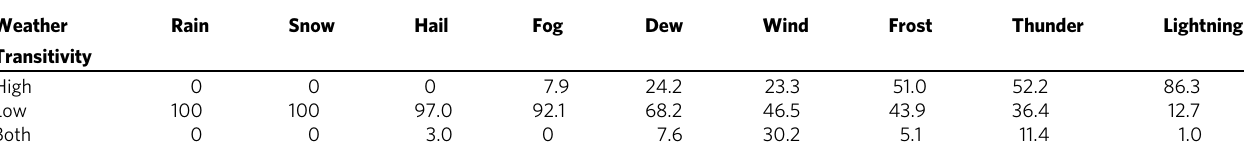
Table 1 Distribution of transitivity degrees of verbs in Sinitic languages